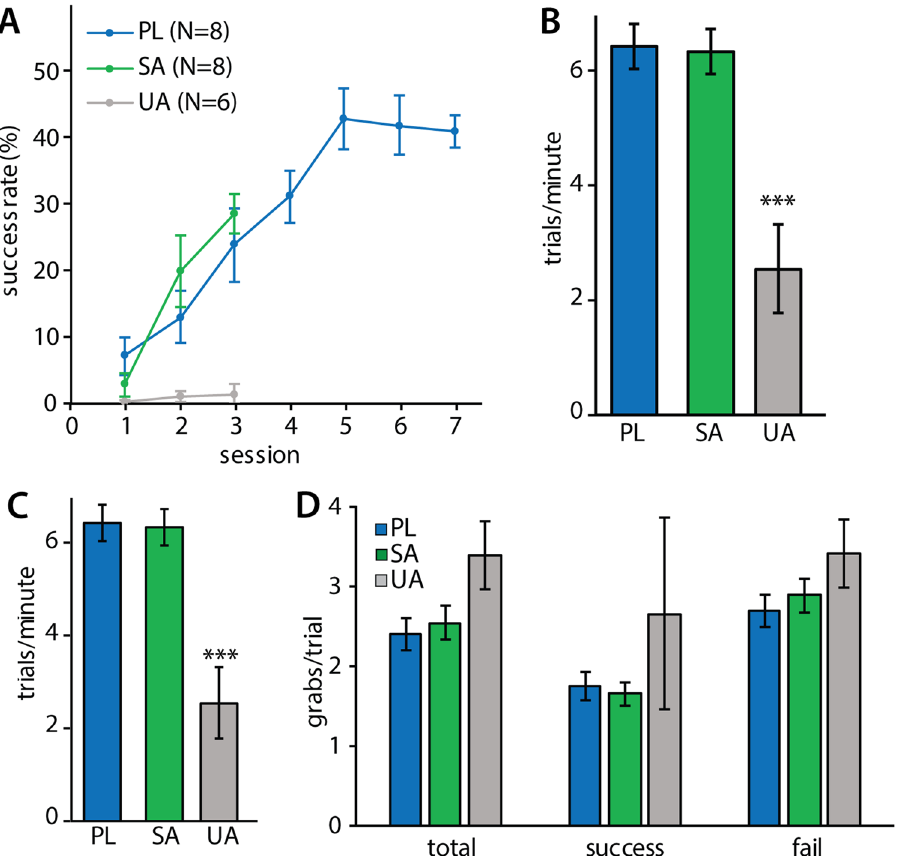
Figure 2. Behaviour of SPR rats during task execution in SA (N = 8), UA (N = 6) and PL (N = 8) experiments. Values are mean ± s.e.m. ( A ) Learning curves showing percentage of successfully obtained pellets per training session. ( B ) Distance walked during the final training session. ( *** p ≤ 0.001 in Tukey’s HSD test) ( C ) Number of trials executed per minute during the final training session. ( *** p ≤ 0.001 in Tukey’s HSD test) ( D ) Number of grabbing attempts per trial in the final training session of SA (N = 8), UA (total and fail: N = 5 of 6, success: N = 2 of 6) and PL (N = 8) rats. 3 rats in the UA experiment did not achieve any successful